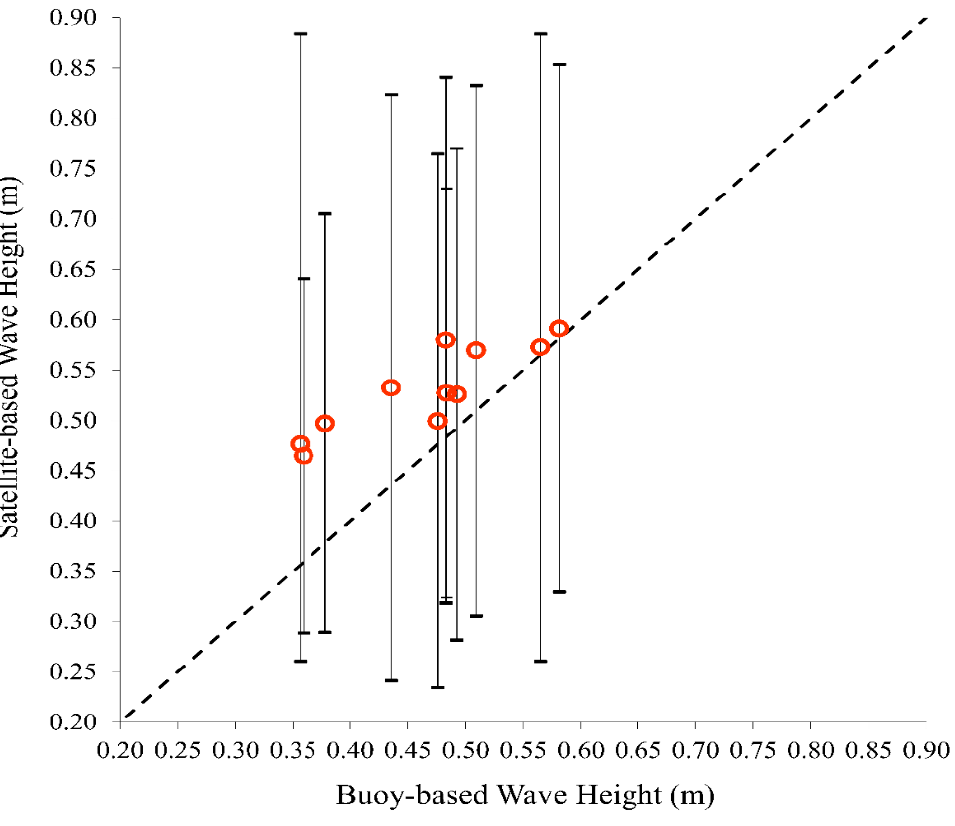
Figure 6. Comparative analysis of monthly average buoy- and satellite-based wave heights (m) over the southern coasts of Caspian Sea flow area in January–November. The black dashed line represents the perfect agreement, while the vertical bars indicate the error bars in terms of ± standard deviation.